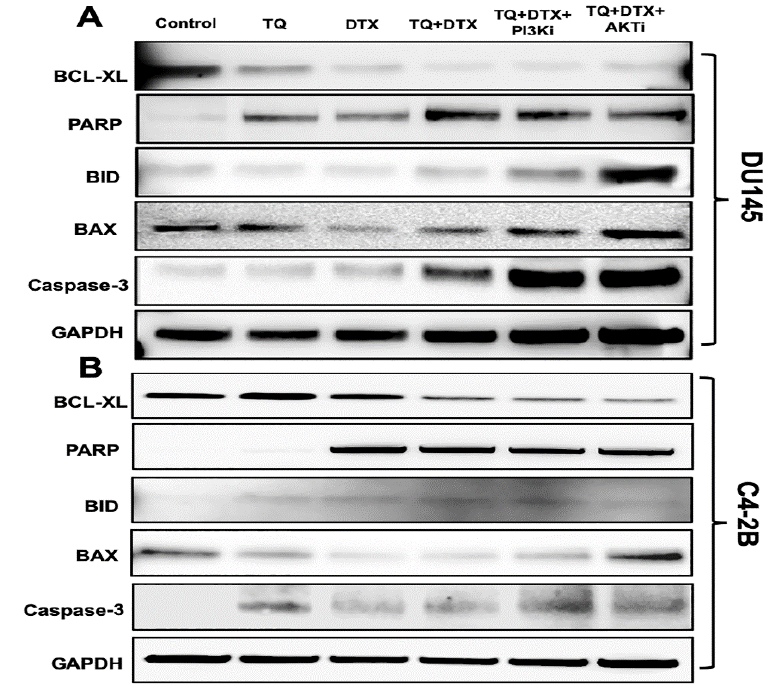
Figure 4. TQ in combination with DTX induces the expression of pro- and anti-apoptotic markers in PCa cells. Immunoblots of ( A ) DU145 and ( B ) C4-2B cells showing the expression of pro- and anti-apoptotic genes after treatment with TQ, DTX, or their combination in the presence or absence of PI3Ki and AKTi inhibitor. After 48 h of treatment with the combination, the pro-apoptotic genes, BAX and BID, and caspase-3 and PARP were upregulated relative to effects of the individual drugs. However, for both cells, the anti-apoptotic gene, BCL-XL, was downregulated by the combination. As an internal standard for equal loading, blots were probed with a GAPDH antibody.